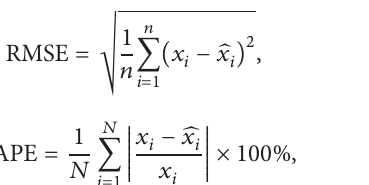
Figure 12: Mean multiple comparisons